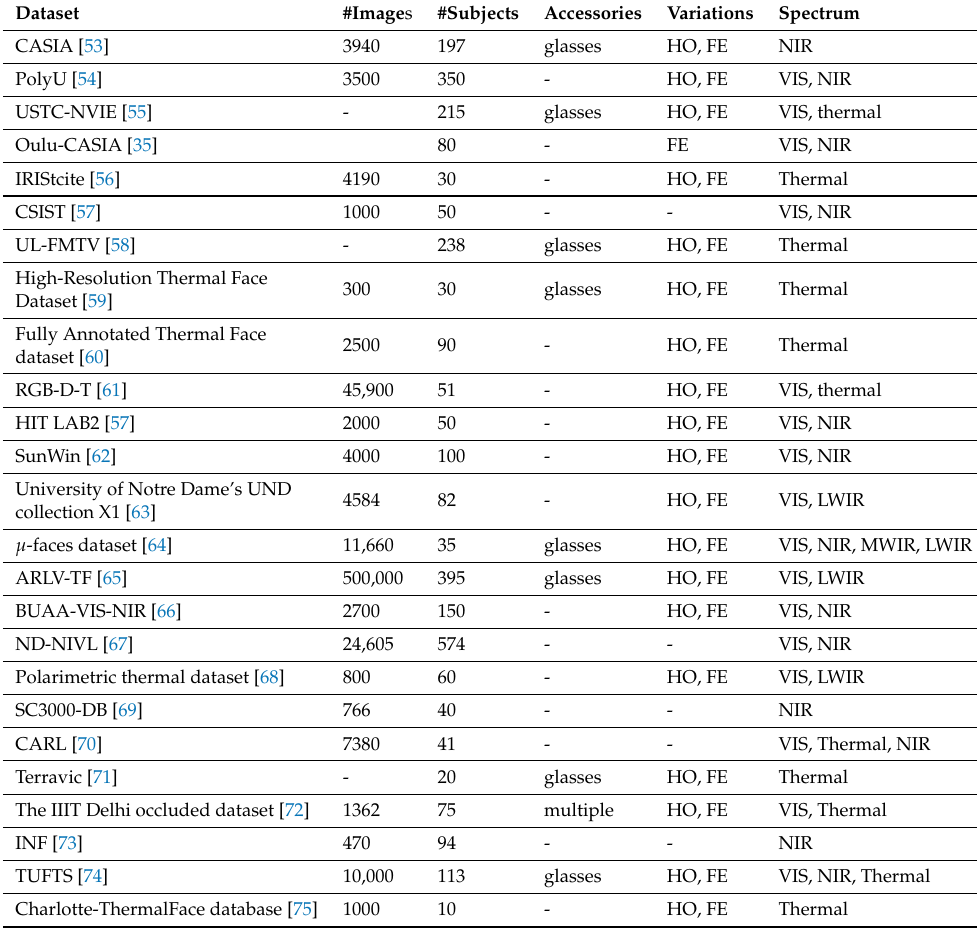
Table 1. IR FR Datasets (HO: Head Orientation, FE: Facial Expression).